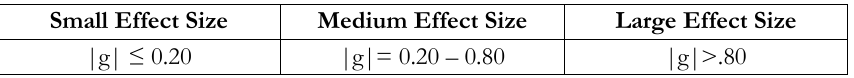
Table 1. Interpretation of Effect Size